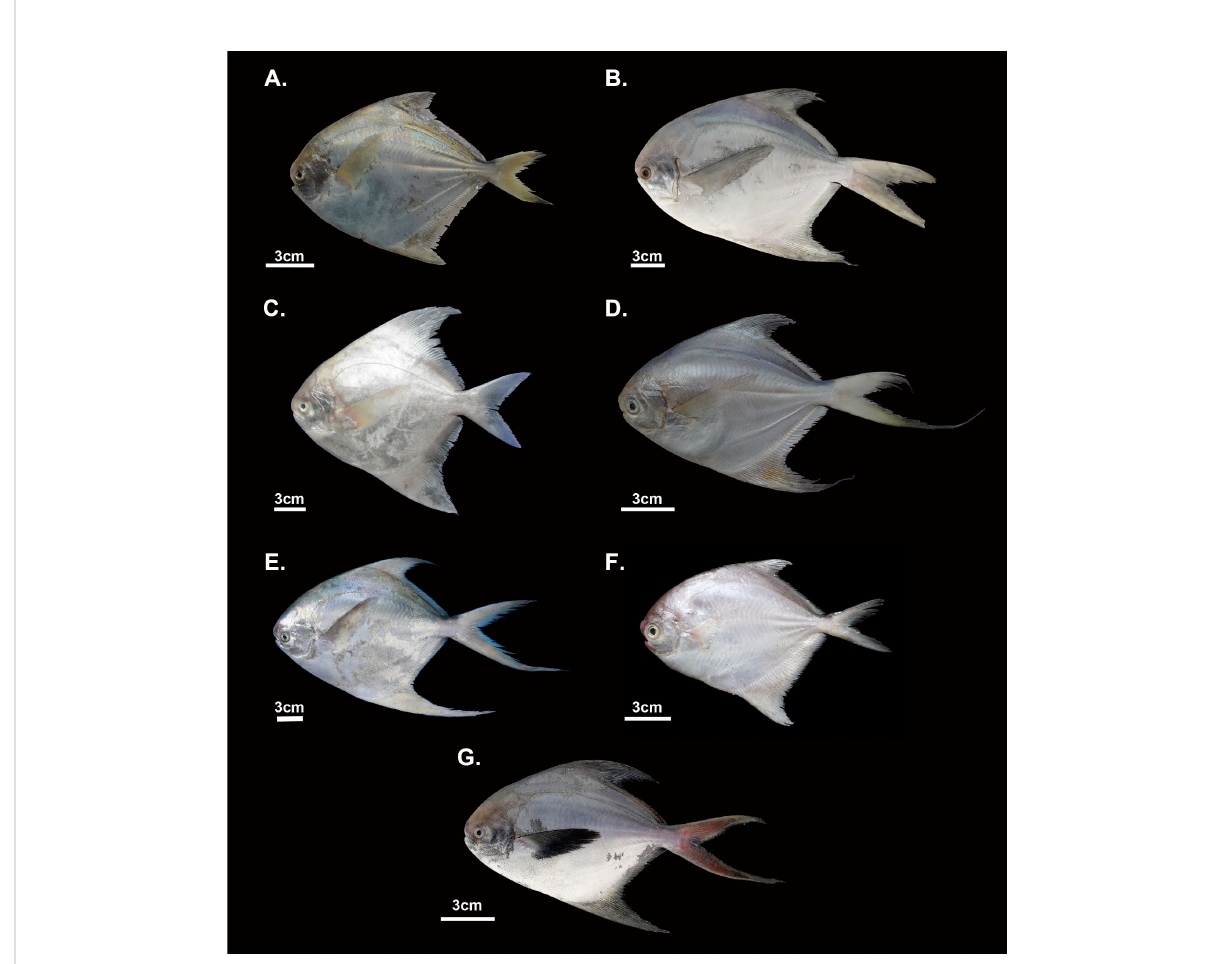
FIGURE 2 Photographs of the seven valid Pampus species. (A) Pampus argenteus (20120469). (B) Pampus candidus (IOCASF000292). (C) Pampus chinensis (201006001). (D) Pampus cinereus (20120481). (E) Pampus liuorum (HBRF03-036). (F) Pampus minor (20120502). (G) Pampus punctatissimus